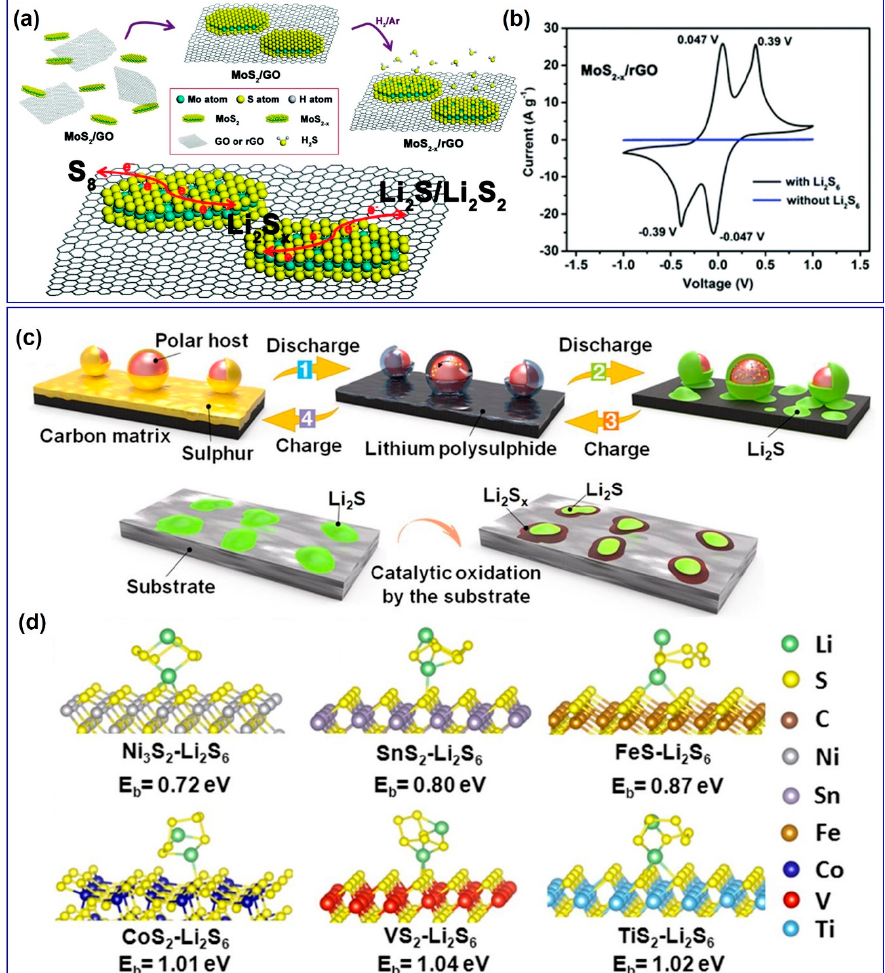
Figure 8. ( a ) Schematic representation of the MoS 2 − x /rGO composite and the conversion of Li 2 S x on its surface. ( b ) CVs of the symmetric cells with identical electrodes containing the electrocatalyst MoS 2 − x /rGO/S. with and without Li 2 S 6 . Reproduced with permission, Copyright, 2016, Royal Society of Chemistry [104] . ( c ) Schematic representation of the sulfur conversion process and the Li 2 S oxidation on the electrocatalytic surface. ( d ) Atomic conformations, and binding energies for Li 2 S 6 species on various metal-sulfide electrocatalytic surfaces. Reproduced with permission, Copyright 2017, National Academy of Sciences [106] .